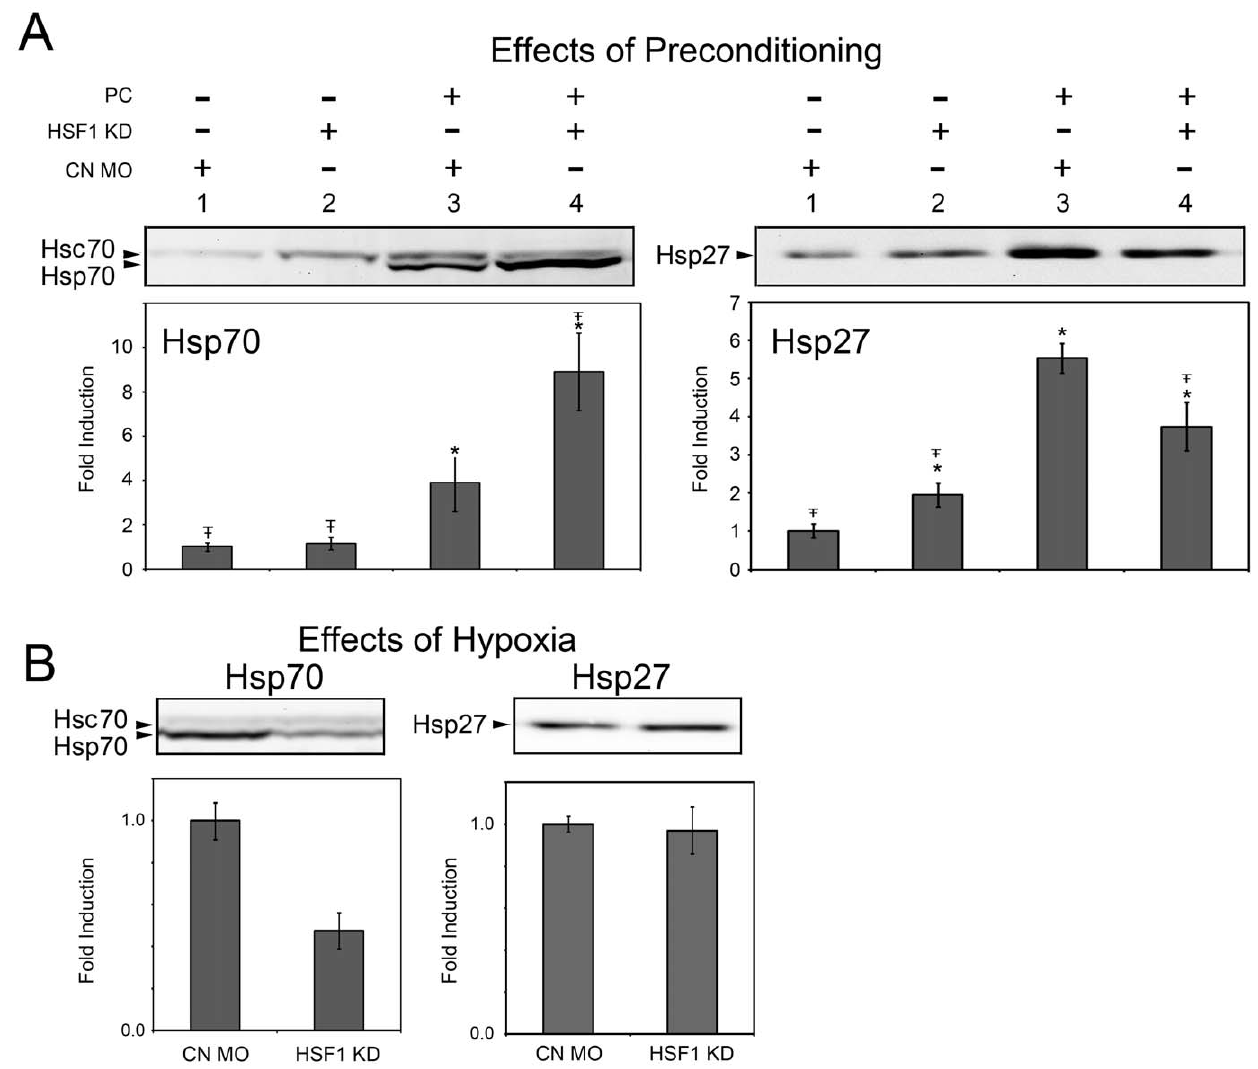
Figure 6. Alterations in heat shock protein expression following HSF1 knockdown. A: Representative Western blots, and quantitative analysis of Hsp70 and Hsp27 expression. Expression was analyzed in 48 hpf embryos injected with control (CN MO) or HSF1 antisense (HSF1 KD) morpholinos incubated at control temperatures or subjected to heat shock preconditioning (PC). Values represent average data from four independent experiments. Error bars are the SD, symbols indicate a significant difference from CN-MO injected embryos that were not preconditioned (*) and from CN-MO injected embryos that were preconditioned (T–). B: Representative Western blots and quantitative analysis of Hsp27 and Hsp70 expression after a 100 min hypoxia treatment. Embryos were injected with HSF1 antisense MO (HSF1 KD) or a control MO (CN). Bars represent data collected from three independent experiments. Error bars are the SEM.